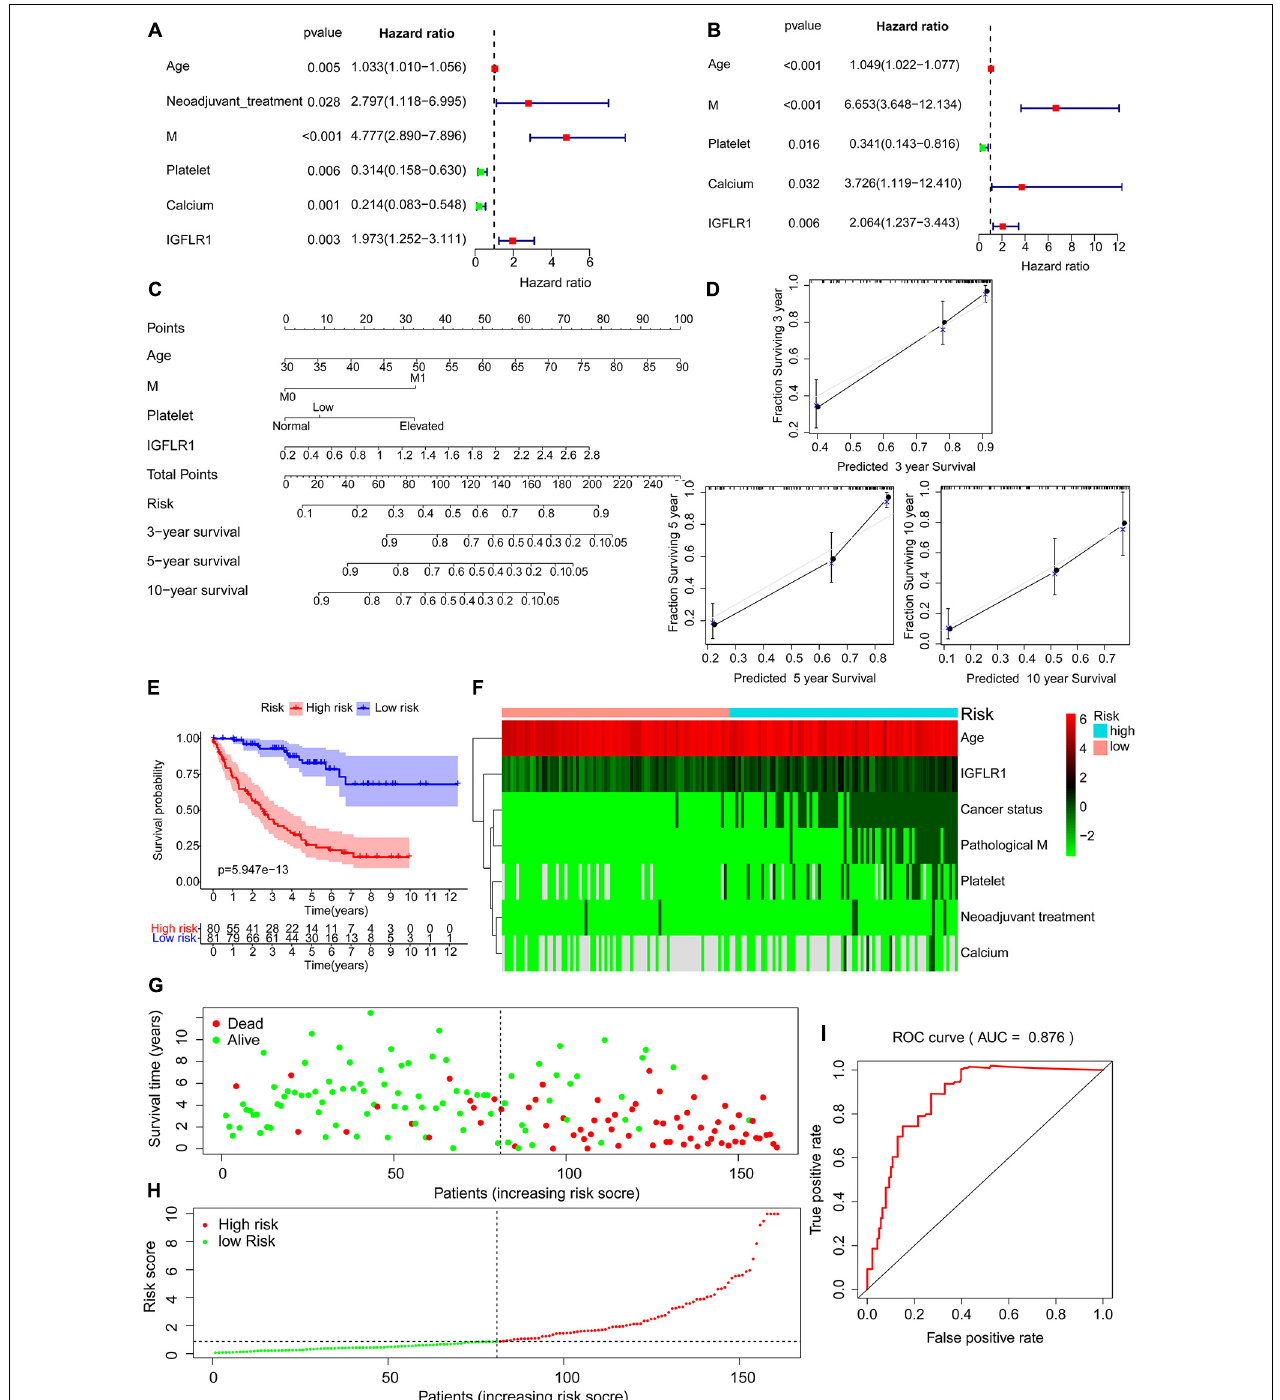
FIGURE 6 | Establishment and evaluation of prognostic risk models. (A) Tree diagram of a univariate regression analysis. (B) Tree diagram of a multivariate regression analysis. (C) The risk score and 3, 5, 10-year survival were used by summing the points identified on the top scale for each independent covariate. (D) Calibration plot of actual (observed) and predicted probabilities for the Nomogram. (E) Survival curve based on risk score according to multivariate regression analysis. (F) The heatmap of prognostic factors after risk score grouping. (G) The plot of survival status. (H) The distribution of risk score. (I) The ROC based on risk score according to multivariate regression analysis. (The risk score was divided into high-risk group and low-risk group with a cut-off value of 50% that was 0.871). (Note: AUC range is 0 ∼ 1, 1 means complete consistency, 0 means complete inconsistency. It is generally believed that the prediction ability of the model is better when the AUC is greater than